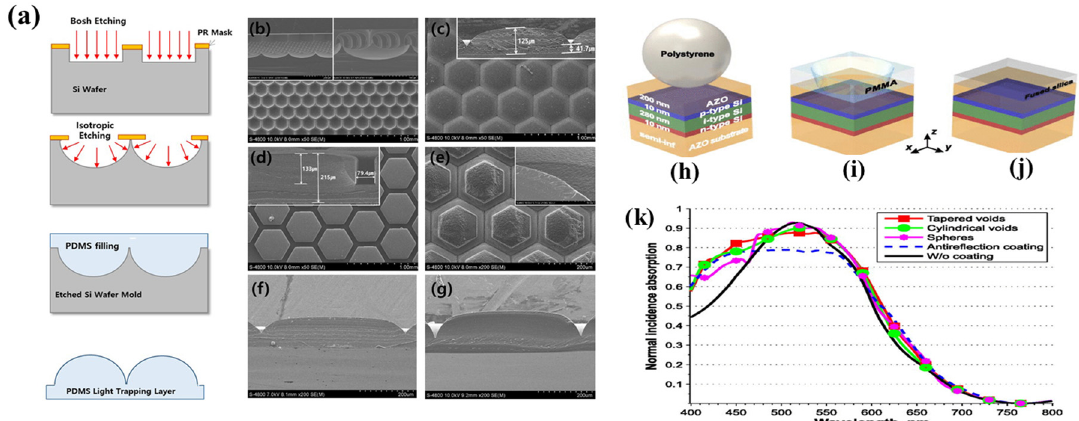
Figure 5. ( a ) Schematic of the fabrication of light-trapping layers, from etching the silicon (Si) wafer to molding the polydimethylsiloxane (PDMS). Scanning electron microscopy (SEM) images of the ( b ) Si wafer master mold in plane and cross-sectional view and light-trapping layers with a ( c ) lens array; ( d ) pillar-shaped lens array; ( e ) lens array with rough surfaces (inset: cross-sections); ( f ) flat-topped lens array, and ( g ) lens array with spaces between patterns. Reprinted with permission from ref. [18]. Copyright 2015 AIP Publishing. ( h – k ) Schematic views of thin-film solar cell with three types of all-dielectric coatings for TFSC: ( h ) a close-packed layer of dielectric (polystyrene) nano- or microspheres; ( i ) a square array of tapered nanovoids in the superstrate, ( j ) a homogeneous film ARC, and ( k ) absorption spectra of the system for the following cases. Reprinted from ref. [19].